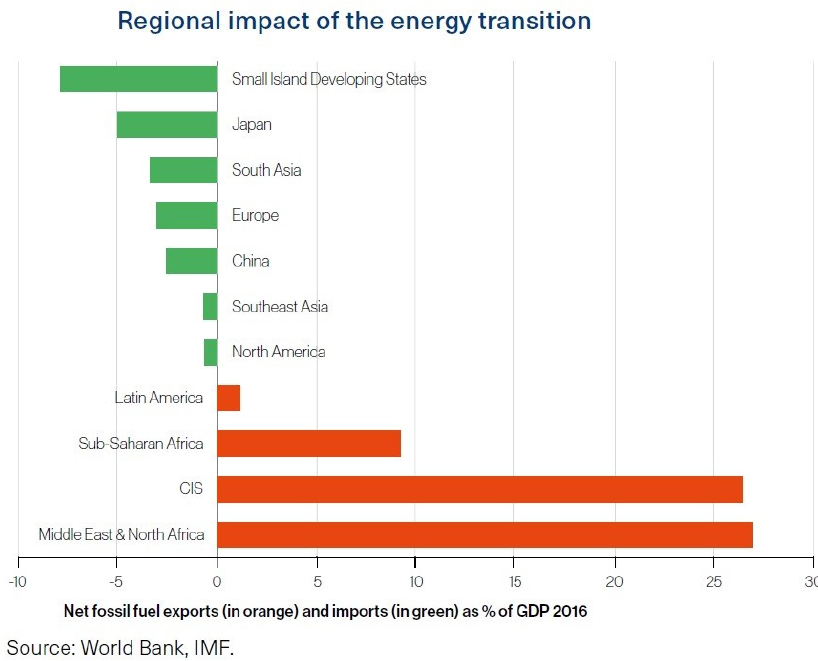
Figure 7. Percentage of regional trade in fossil fuels to GDP [15].